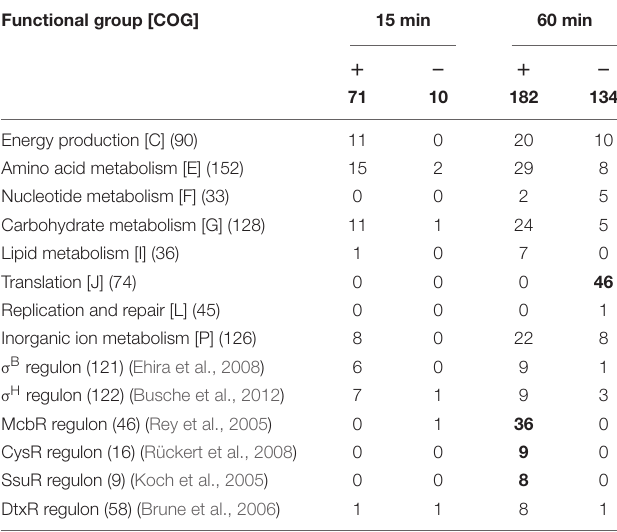
TABLE 3 | Analysis of (p)ppGpp-dependent differentially transcribed genes with regard to their affiliation to (p)ppGpp metabolism associated functional groups of the Clusters of Orthologous Groups (COGs) scheme (Tatusov et al., 2000; Meyer et al., 2003), as well as their membership to regulons of various sigma factors and regulators of sulfur and iron